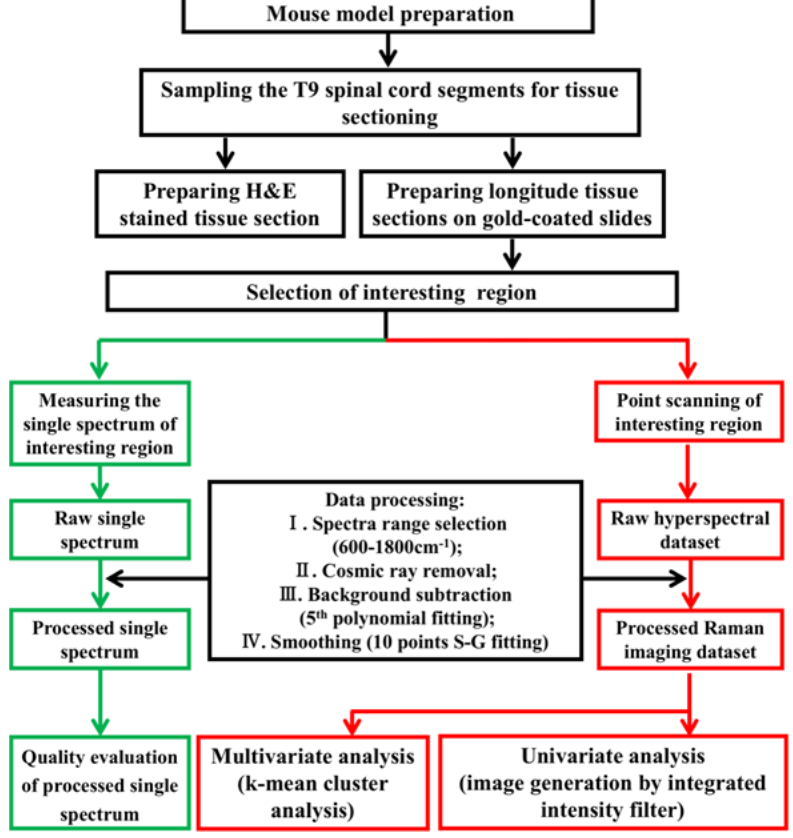
Fig. 1. A °owchart of all experimental steps used to analyze spectral information about mouse spinal cord